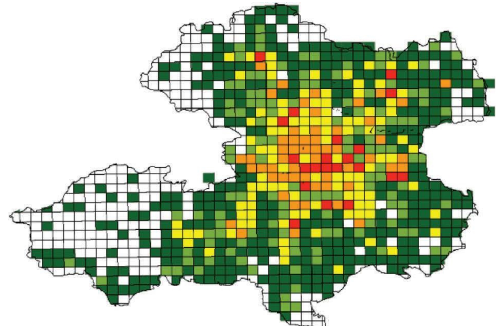
Figure 12: Distribution of restaurants.